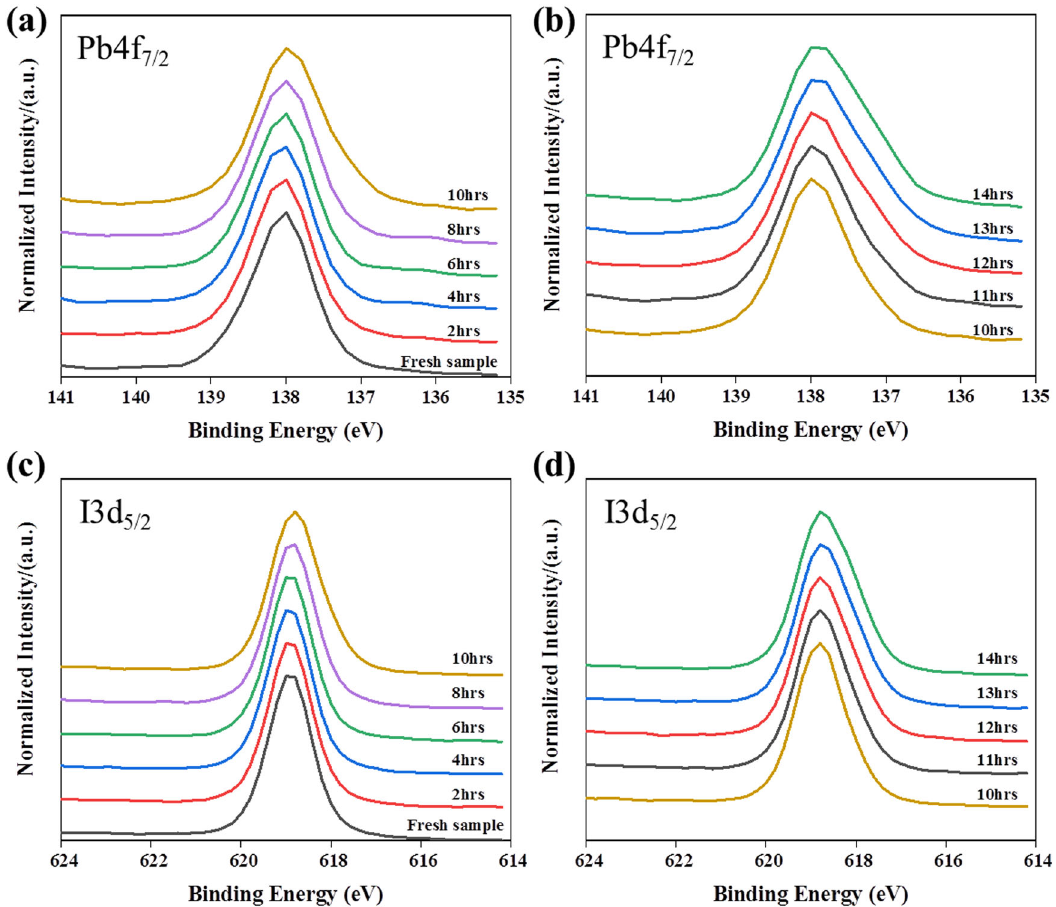
Fig. 3 Study of chemical states of lead and iodine under X-ray illumination for 0 – 14 h. XPS spectra of Pb4f 7/2 ( a , b ) and I3d 5/2 ( c , d ) with X- ray exposure from 0 to 14 h. The duration of the X-ray exposure in the fi gure do not include the X-ray irradiation during XPS measurements. The X-ray exposure during the measurement of the each sample was limited to <20